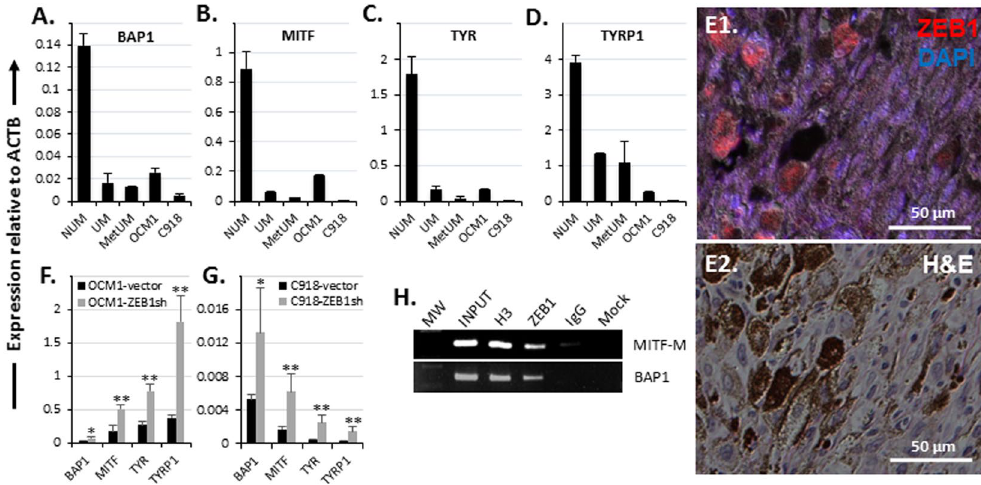
Figure 4. ZEB1 promotes UM cell dedifferentiation by repressing the pigment synthesis pathway. A significant underexpression of genes involving in melanocyte differentiation such as ( A ) BAP1 , ( B ) MITF , ( C ) TYR , and ( D ) TYRP1 was detected in UM and MetUM as compared to NUM. Higher expression of these differentiation genes was also detected in the spindle non-aggressive OCM1 as compared to the epithelioid aggressive C918. ( E ) ZEB1 was only detected in the epithelioid cells which manifested non- or less pigment in a representative patient UM section. An H&E stained section of the same area is included to show the mixed phenotype. Knockdown of ZEB1 significantly amplified transcription of all these differentiation genes in both ( F ) OCM1 and ( G ) C918. ( H ) ChIP assays showed that ZEB1 bound to MITF-M (melanocyte-specific) and BAP1 promoters, likely to repress their expression. Mean (M) ± standard deviation (SD). ‘ * ’ Indicates Student’s t-test p ≤ 0.05, ‘ ** ’ Indicates Student’s t-test p ≤